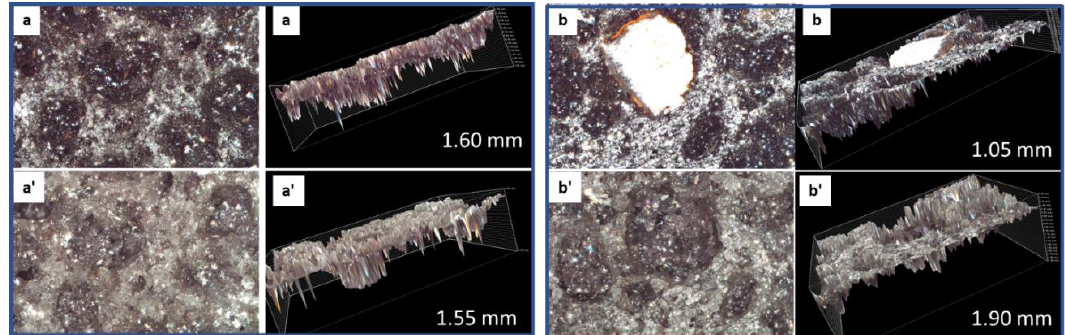
Figure 8. 3D images of aluminum oxide before (top row: ( a , b )) and after (bottom row: ( a’ , b’ )) the acid exposure for two different sites. The numbers indicate the depth of the sample features on 3D images.